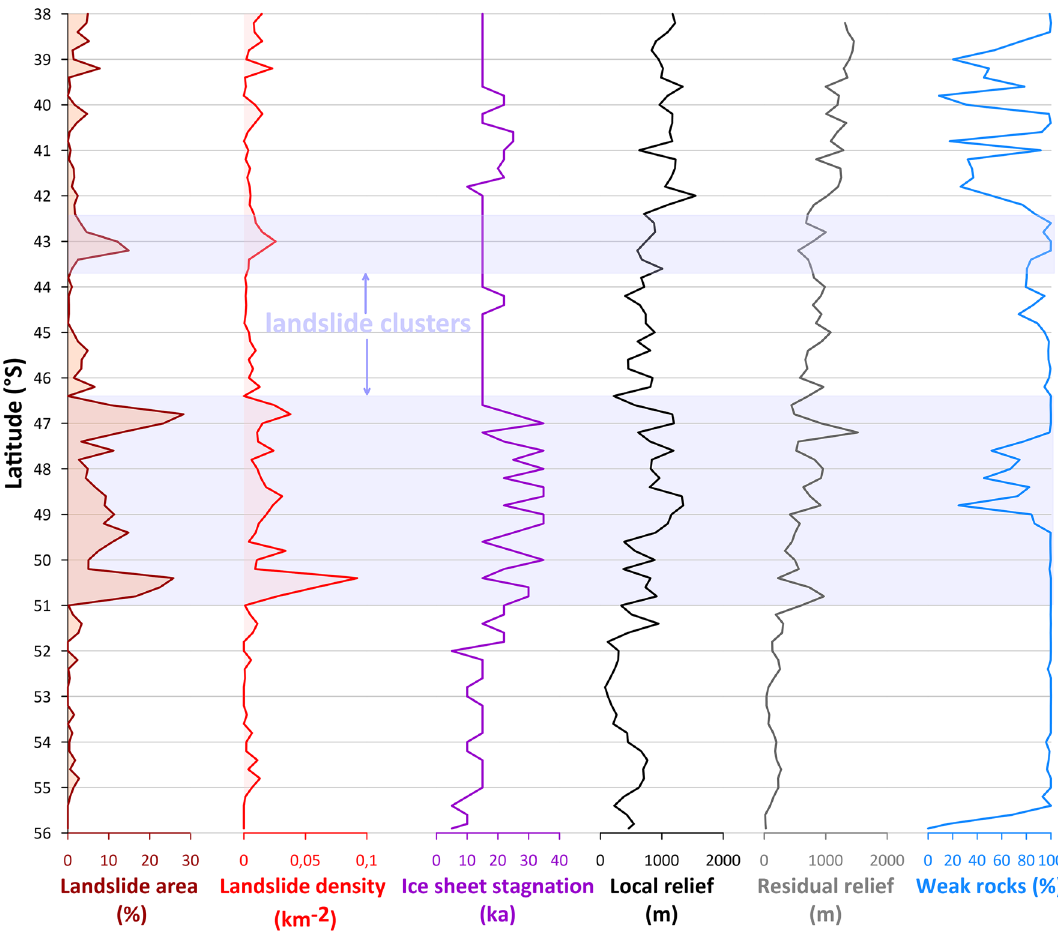
Figure 6. Distribution of large landslides (expressed as landslide area and density) within 10-km-wide zone along the eastern LGM margin of the PIS, plotted against selected landscape variables calculated for 2° bins of latitude. Ice sheet stagnation means how long ice margin stayed within 10-km wide belt from the 35 ka LGM outline (calculated as subtraction of the youngest age of glacier presence within the given bin from 35 ka). Topographic parameters (local relief, residual relief) were calculated from NASADEM. Weak rocks are all except crystalline (plutonic and metamorphic)